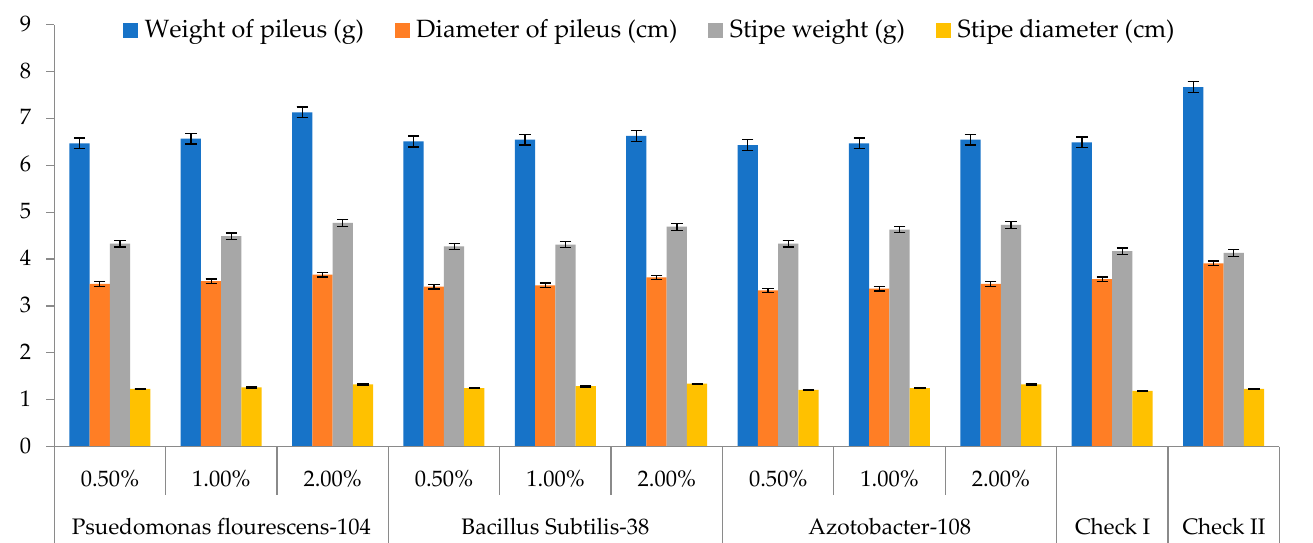
Figure 2. In vivo efficacy of bacterial antagonists on quality parameters of white button mushrooms at concentrations between 0.5 to 2%. Values are the mean and standard errors of three replications; Check-I = infested-untreated; Check-II = uninfested-untreated.